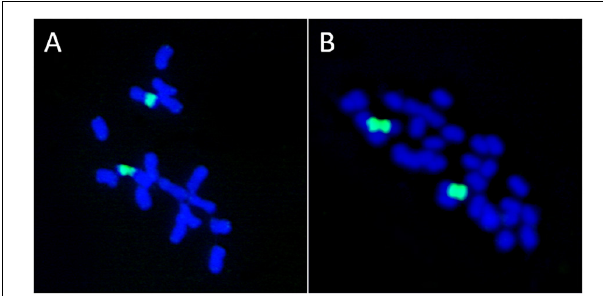
FIGURE 4 | Lack of association between the number of ribosomal loci and polyploidy. (A) Medicago marina , 2 n = 2x = 16. (B) M. arborea , 2 n = 4x = 32. Both species possess a single 35S rDNA locus as revealed by FISH (green